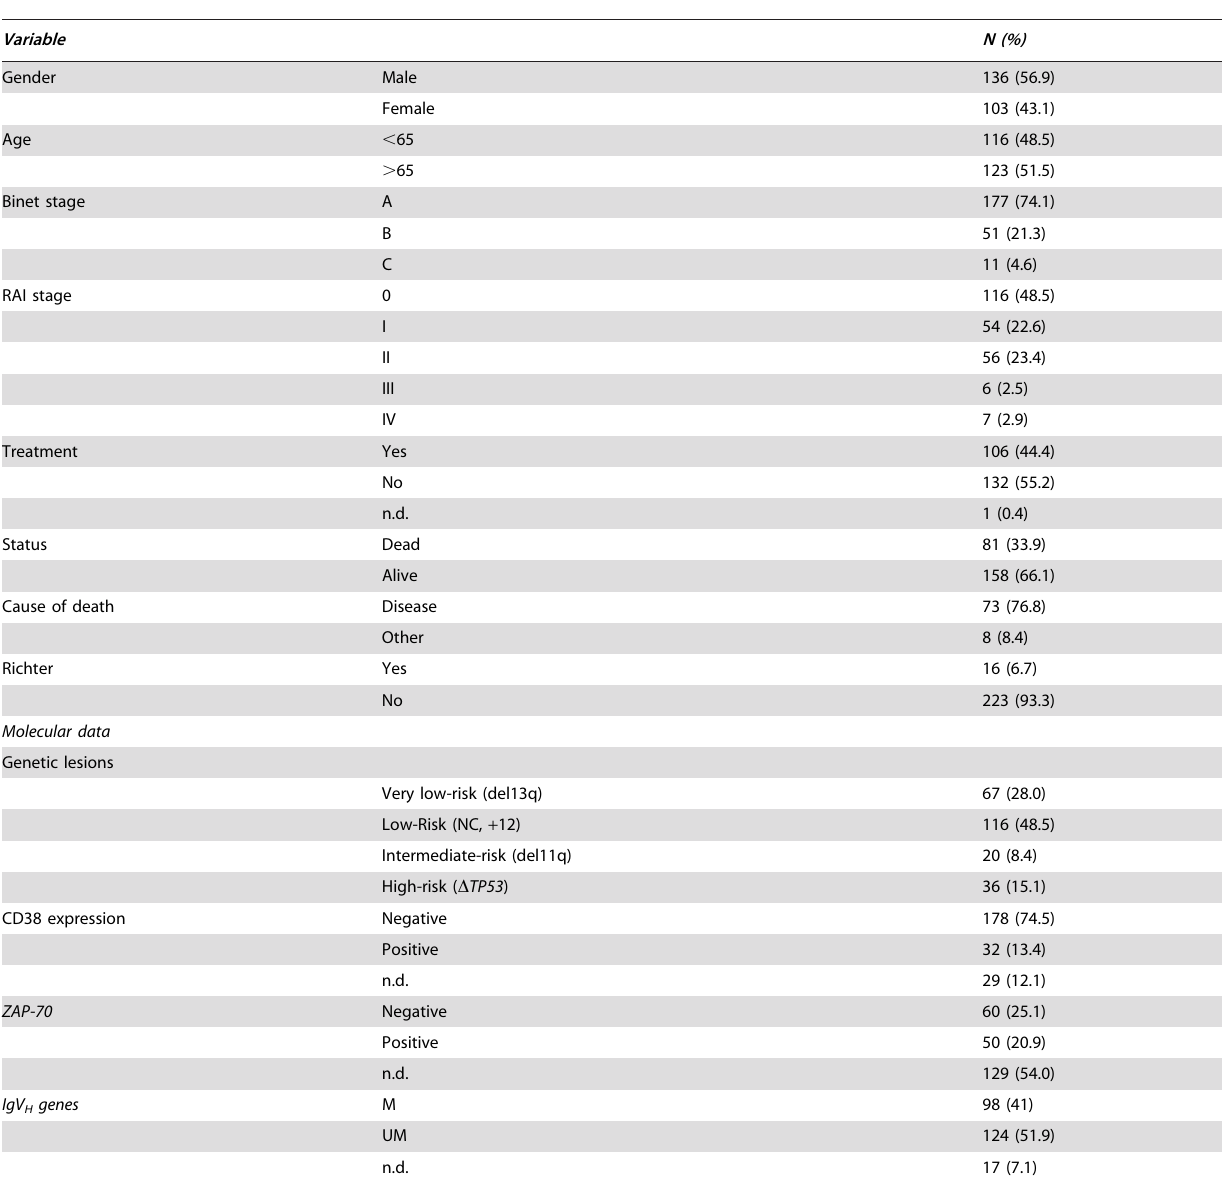
Table 1. Clinical and molecular characteristics of the CLL patients.